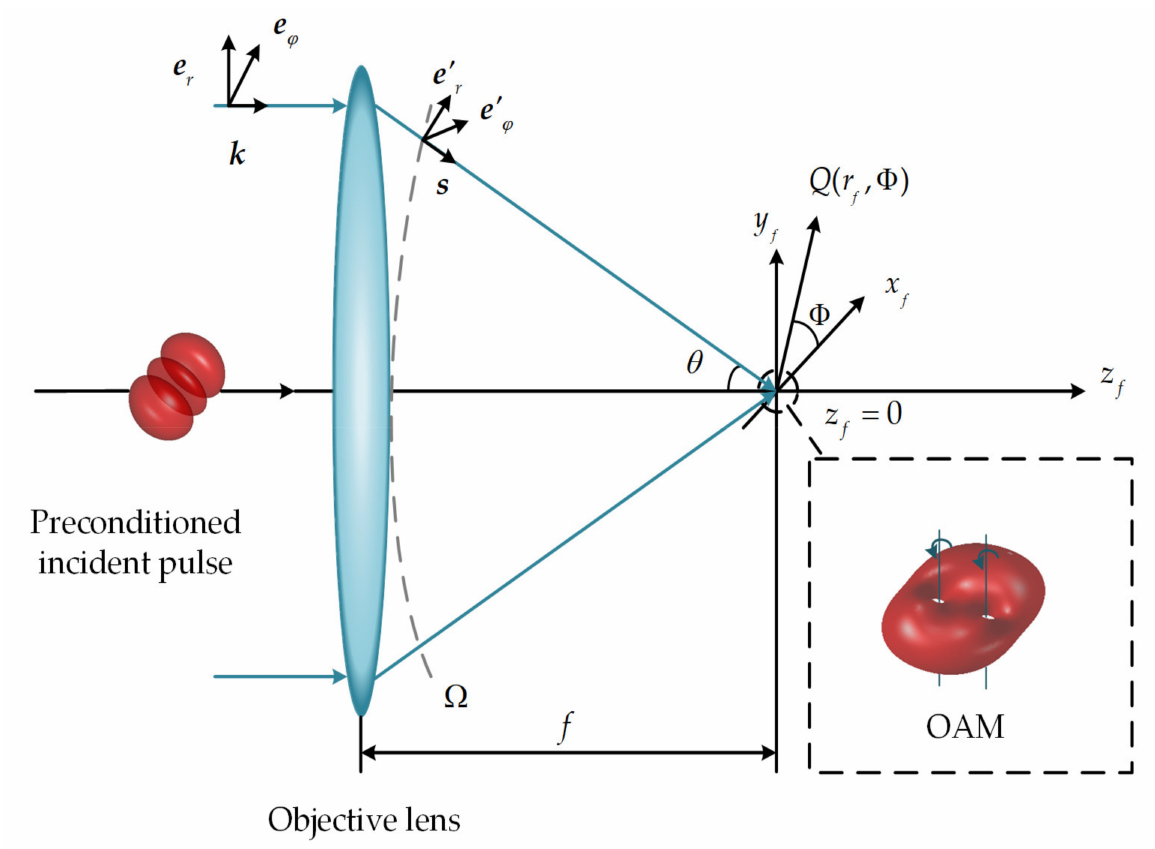
(cid:16) (cid:17) r f , Φ is an arbitrary